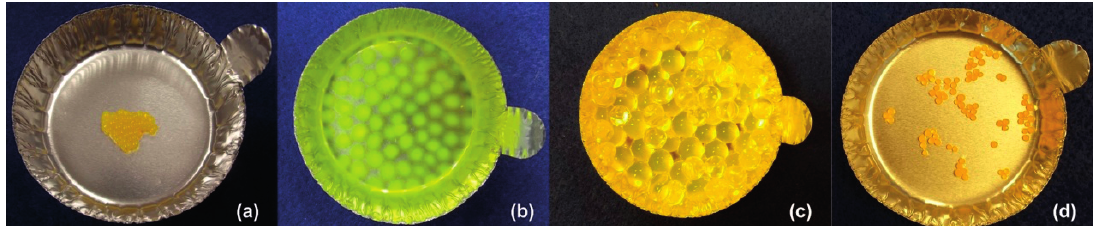
Figure 22. Disassembly upon wetting by hot water. ( a ) Assembled shape; ( b , c ) disassembly process; and ( d ) after drying.